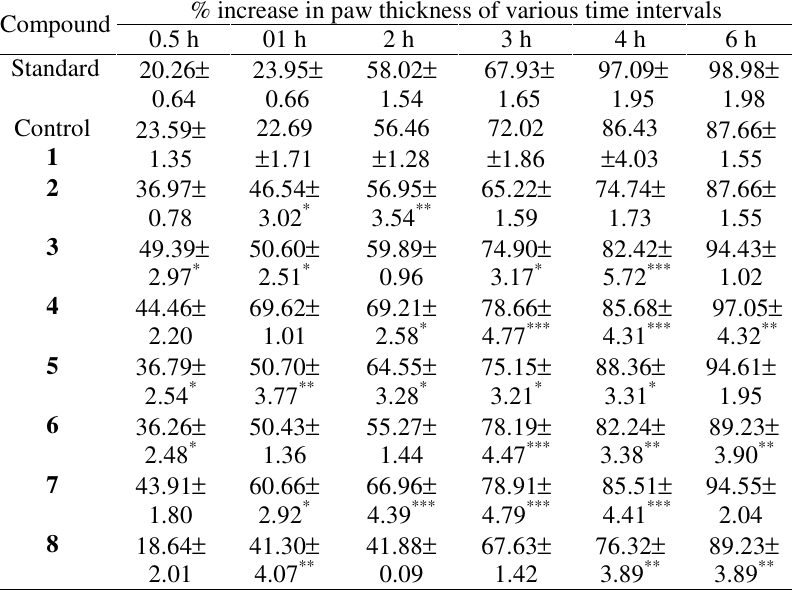
Table 3. Anti-inflammatory activity of the compounds ( 1-8